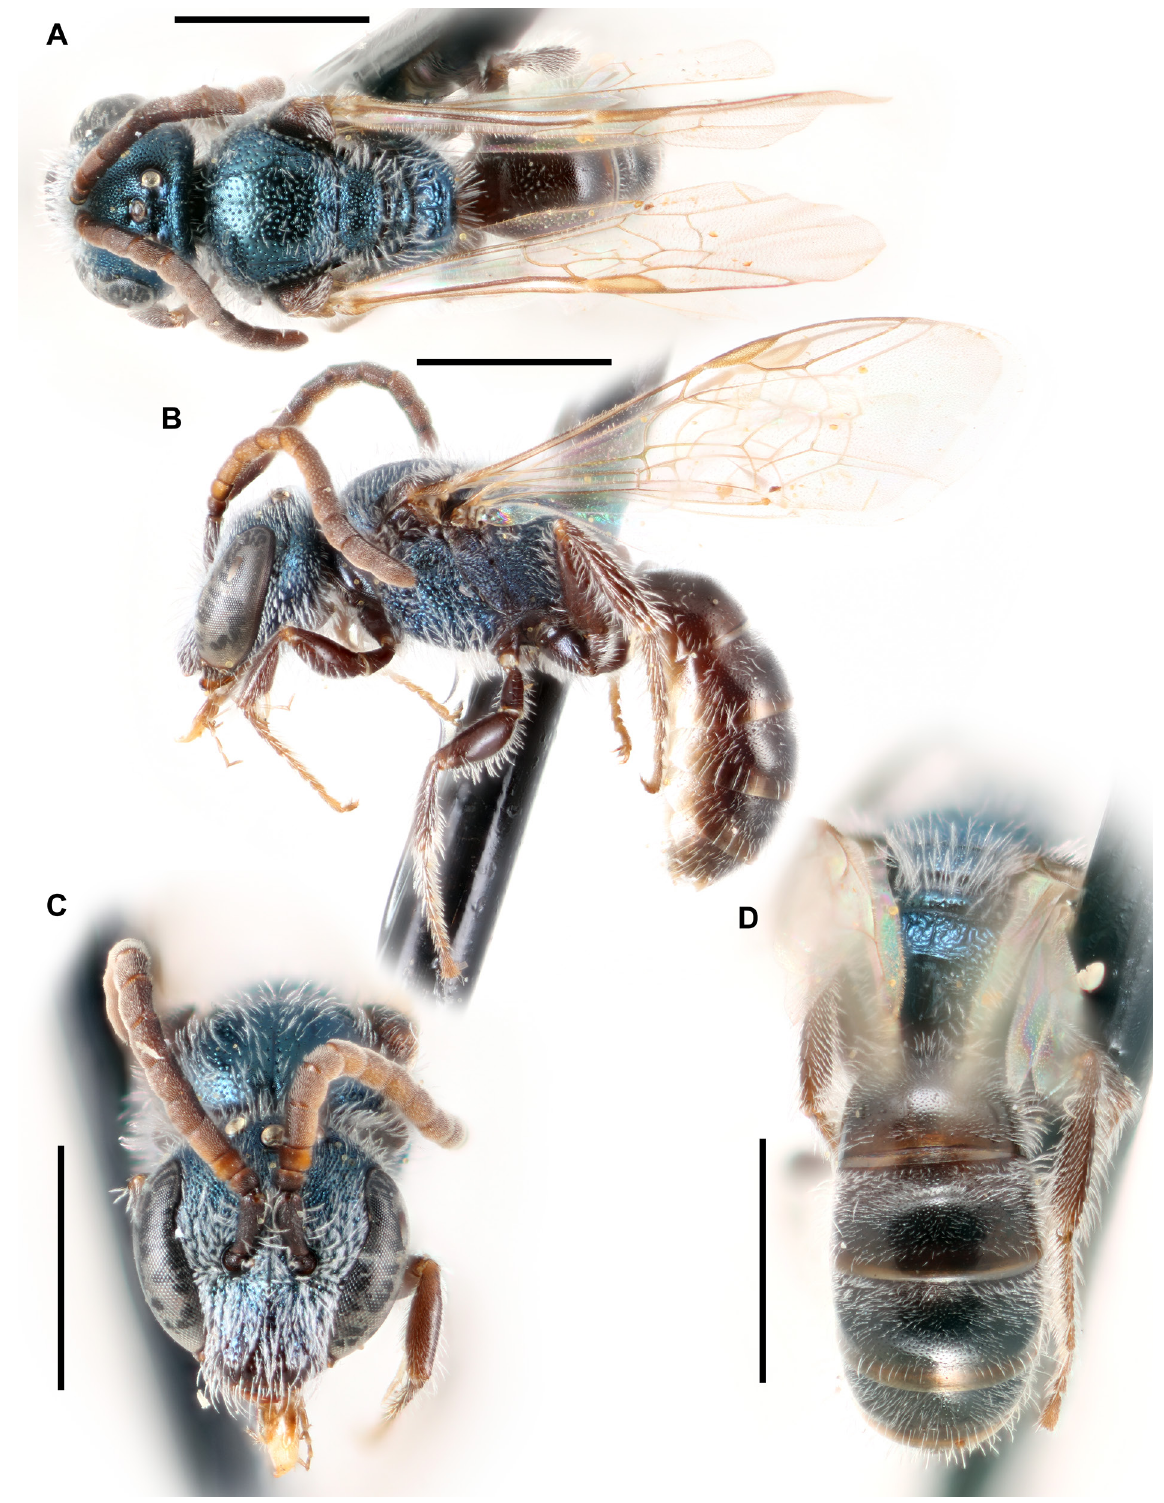
Fig. 22. Lasioglossum ( D .) eremum sp. nov., ♂ (SEMC). A . Dorsal habitus. B . Lateral habitus. C . Face. D . Metasoma and propodeum. Scale bars = 1